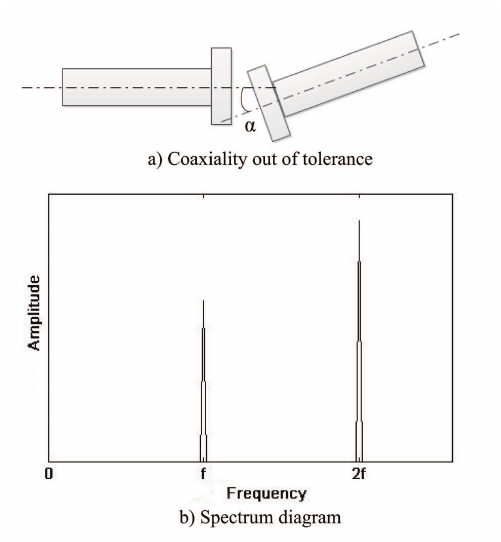
Figure 1. Axis misalignment fault and spectrum diagram. ( a ) Coaxiality out of tolerance. ( b ) Spectrum diagram.